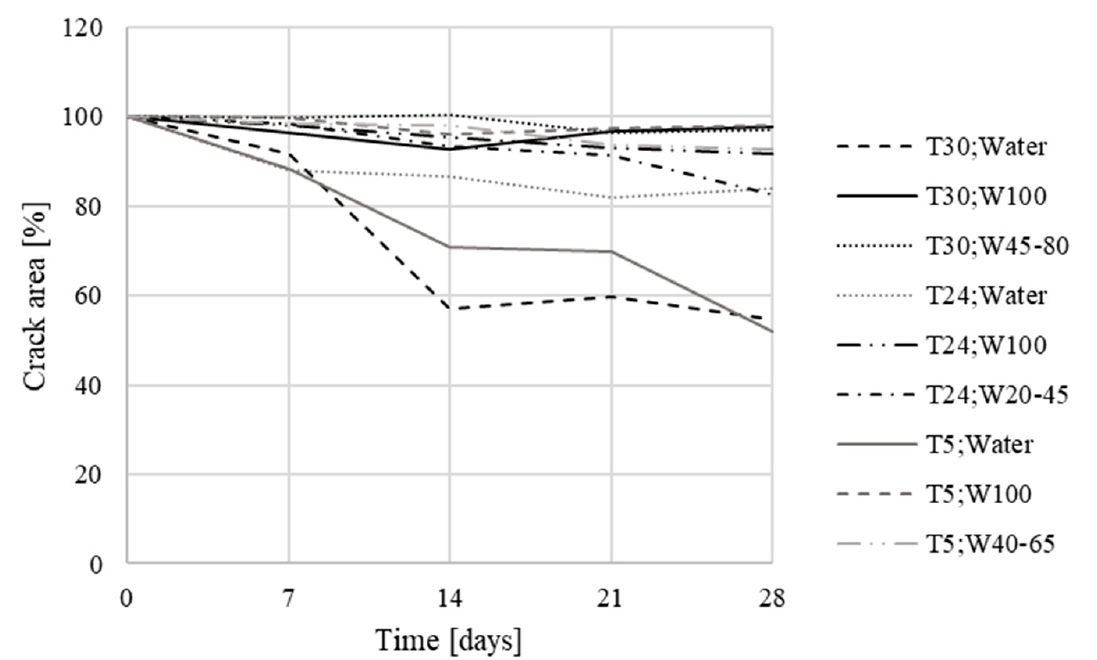
Figure 11. Crack development in reference specimens—the first phase (T = temperature, W = humidity). Table 8. Comparison of crack development—the first